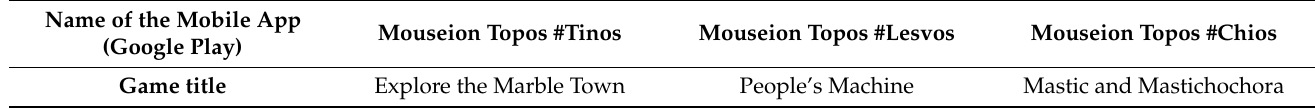
Table 2. Mobile app names (play store) and game